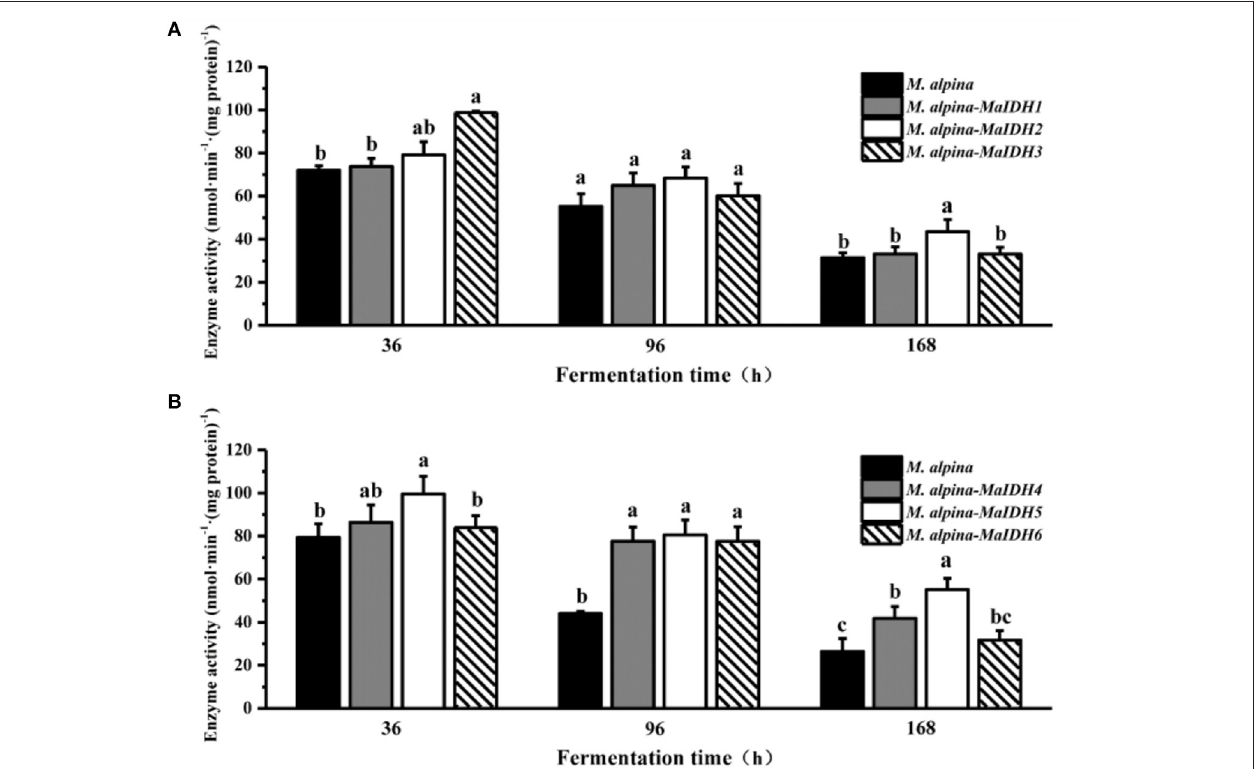
FIGURE 5 | Enzyme activity of isocitrate dehydrogenases from M. alpina (MaIDHs) expressed by recombinant strains at different time points (36, 96, and 168h). (A) Changes in enzyme activity of NAD + -MaIDHs, (B) changes in enzyme activity of NADP + -MaIDHs. Different letters indicate significant differences, p < 0.05.